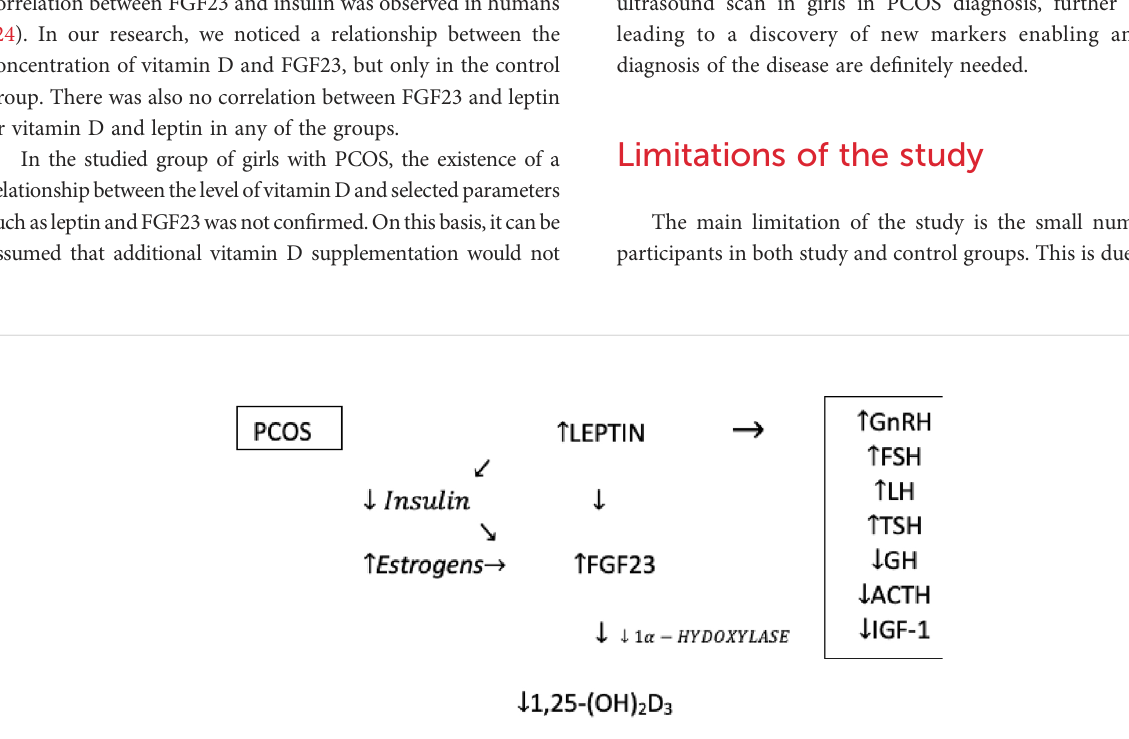
FIGURE 2 Potential relationship between leptin, FGF23 and vitamin D levels in patients with PCOS.